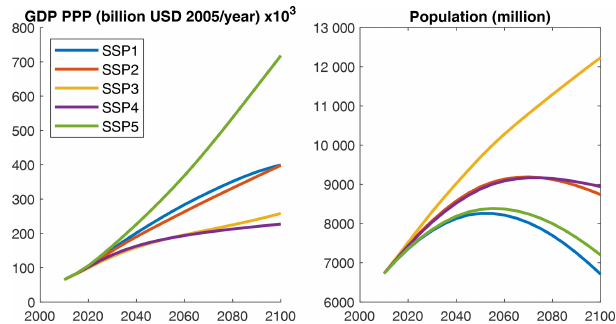
Figure 12. SSP GDP and population variation until 2100, at the global scale, by the IIASA GDP